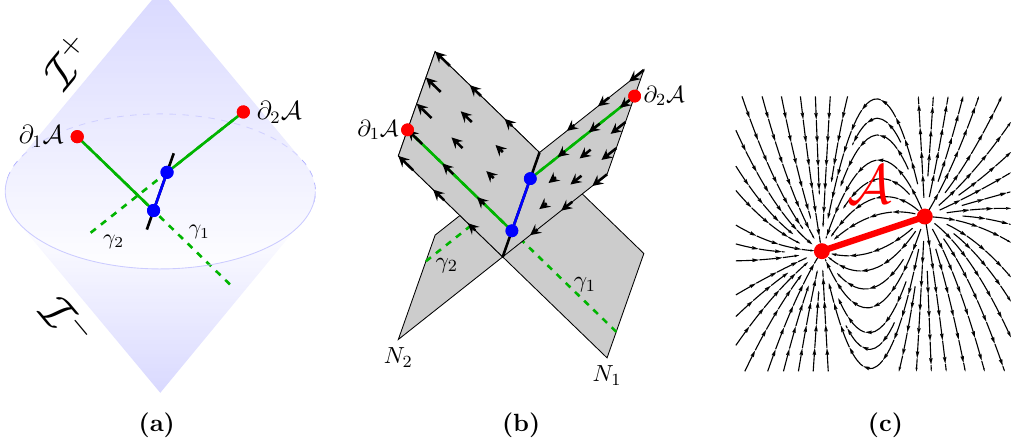
Figure 1. a) Holographic entanglement entropy as understood in [18]. The green lines (cid:13) i are null geodesics falling from the null boundary I + at the endpoints of the region A . The blue space- like geodesic represents the (cid:12)xed points of the bulk replica symmetry. b) Picture of bulk modular (cid:13)ow. The gray planes ( N i ) correspond to the codimension one Cauchy Horizon of the (cid:13)at space cosmological solution. The green lines are null, and we have dubbed them (cid:13) 1 and (cid:13) 2 throughout this note. The black arrows stand for the modular (cid:13)ow vector in the bulk, which vanishes at the intersection between the two planes; N 1 \ N 2 . The extremal path connecting the boundary endpoints is then formed by null lines tangent to modular (cid:13)ow (green) and the (cid:12)xed points of replica symmetry (blue). c) Modular (cid:13)ow at the null boundary I + . The axis are (cid:30); u . The red line is the boundary region A whose entanglement entropy is being